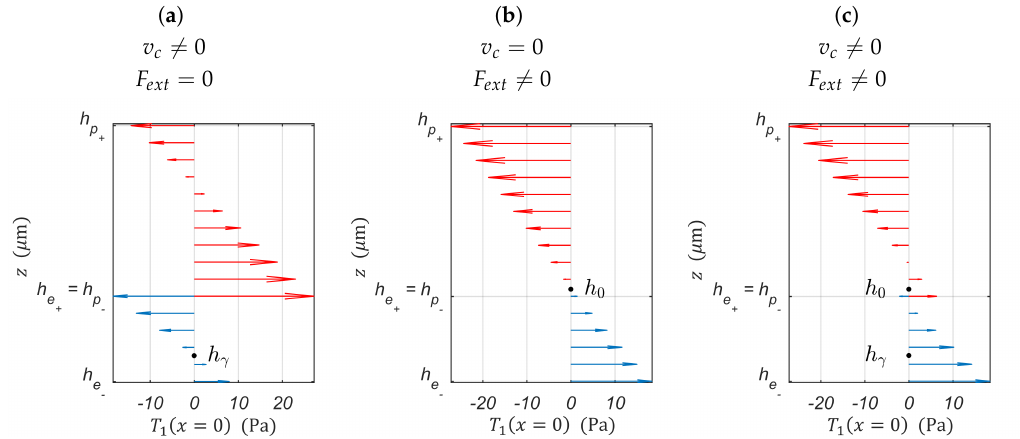
Figure 3. Stress distribution of a cantilevered piezoelectric unimorph ( h p = 100 µ m and h e = 50 µ m): → piezoelectric layer’s stress distribution and → elastic layer’s stress distribution. The piezoelectric material used for this stress distribution is the PSI-5H4E ( d 31 = − 320 × 10 − 12 C/N, = 1.6129 × 10 − 11 m 2 /N), and the elastic layer is Ni ( s 11 s p 11